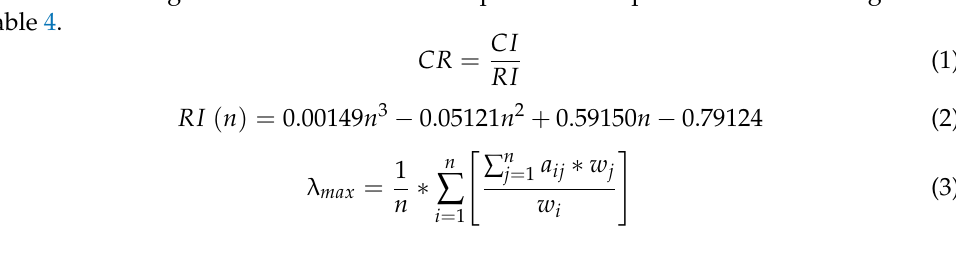
Table 4. The weights of evaluation